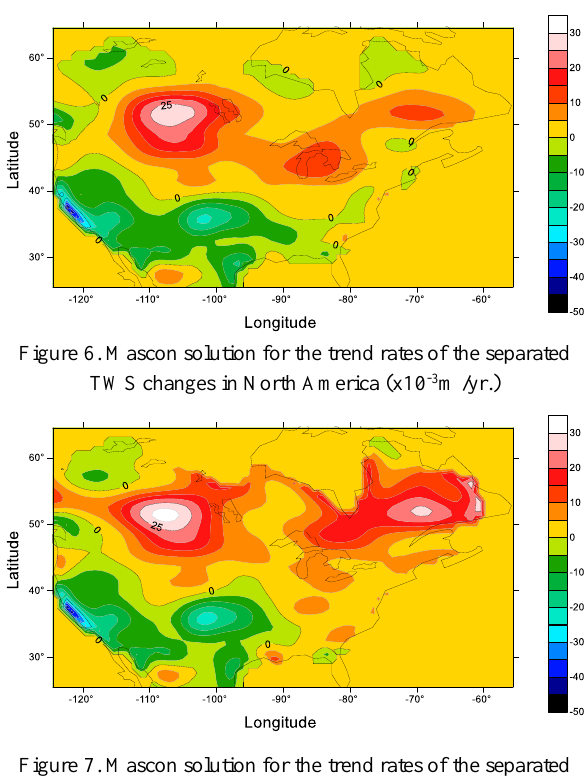
Figure 3. Trend rates of the soil moisture changes in North America (x10 -3 m /yr.)